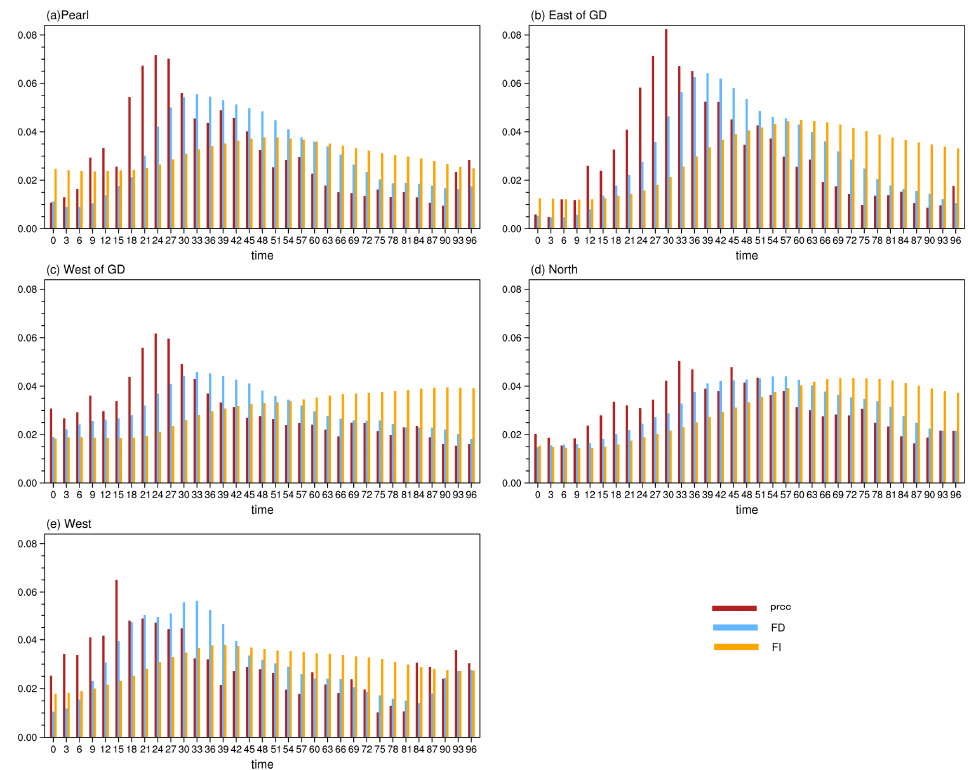
Figure 7. Time series of precipitation, flood duration, and flood intensity during 24 h before through 72 h after typhoons made landfall (24 h represents the landing or nearest time, and all the data were